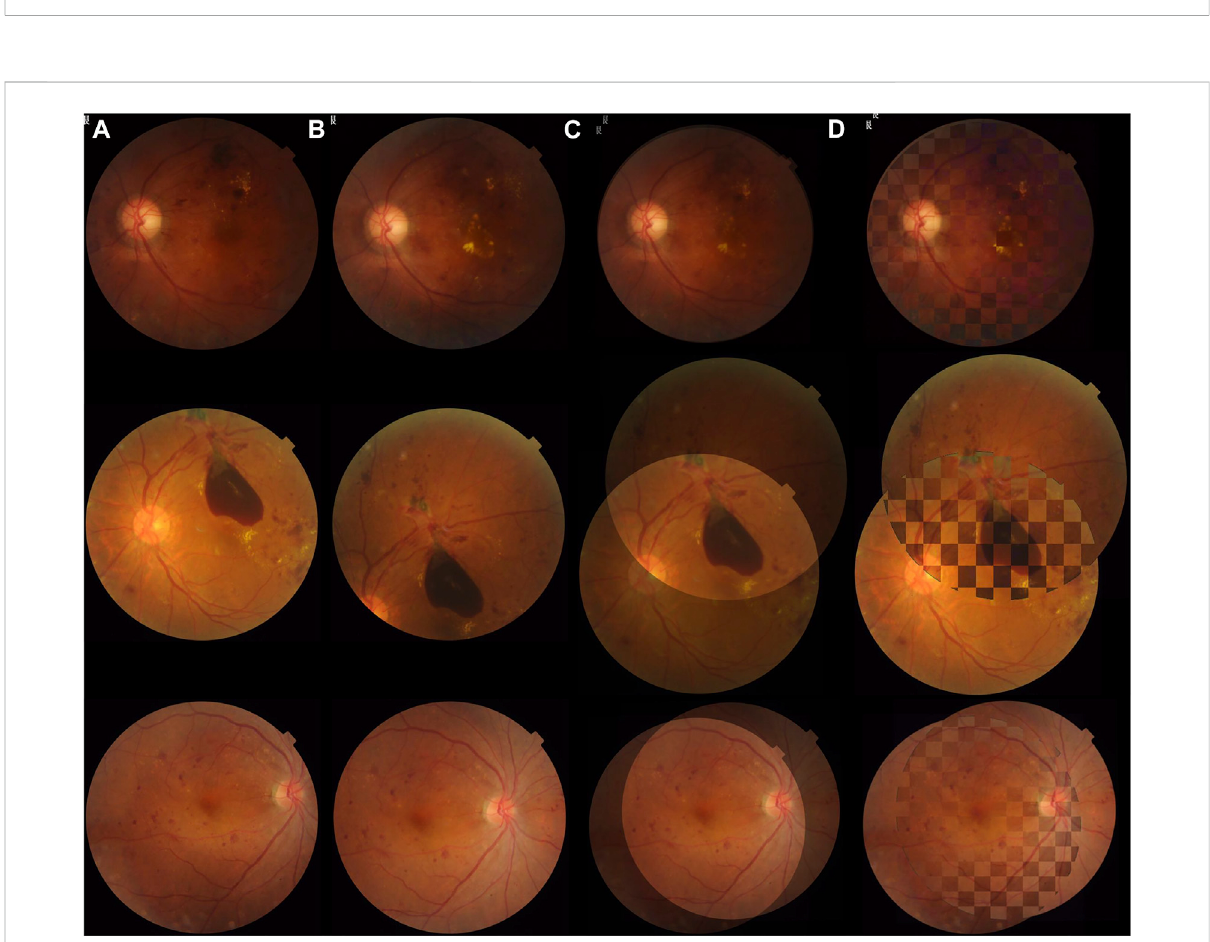
FIGURE 5 Registration results of the proposed algorithm in FI-LORE. The pairs listed, respectively, represent poor illumination quality, pathological change, and disease progression, which are common conditions in longitudinal examinations. (A) and (B) are image pairs without registration. (C) Image pairs shown in an overlaying form after registration. (D) Checkerboard comparisons of the proposed